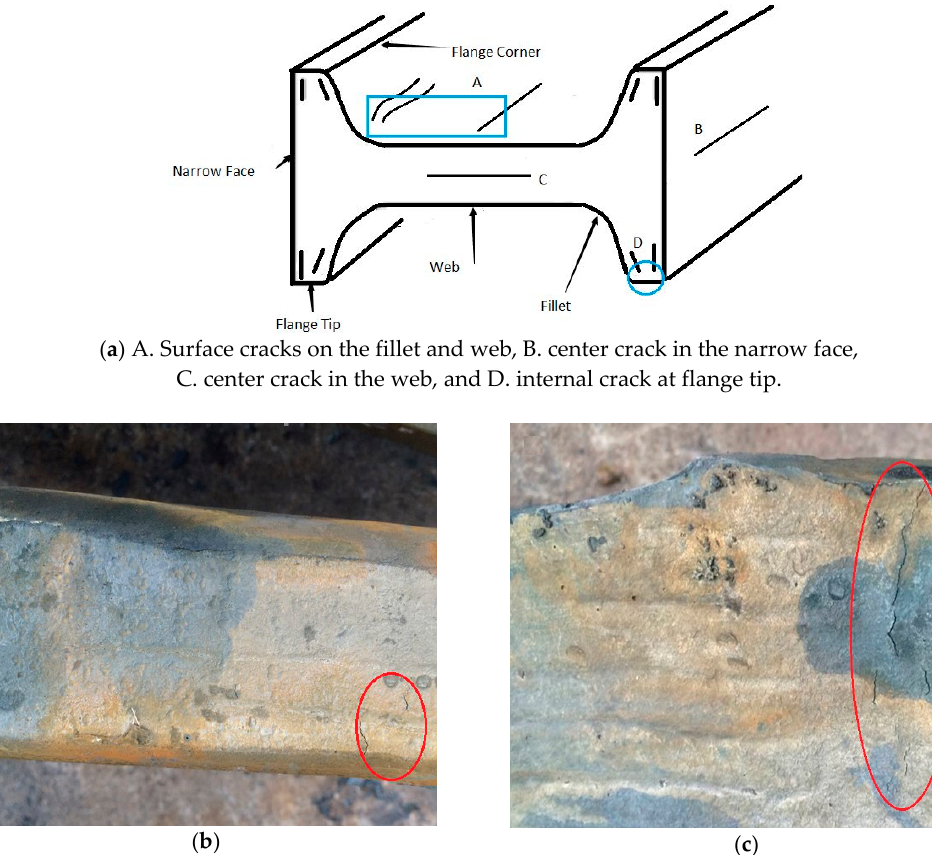
Figure 1. ( a ) Cross-section schematic of beam blank; ( b ) surface cracks on web and ( c ) fillet of actual beam blank.